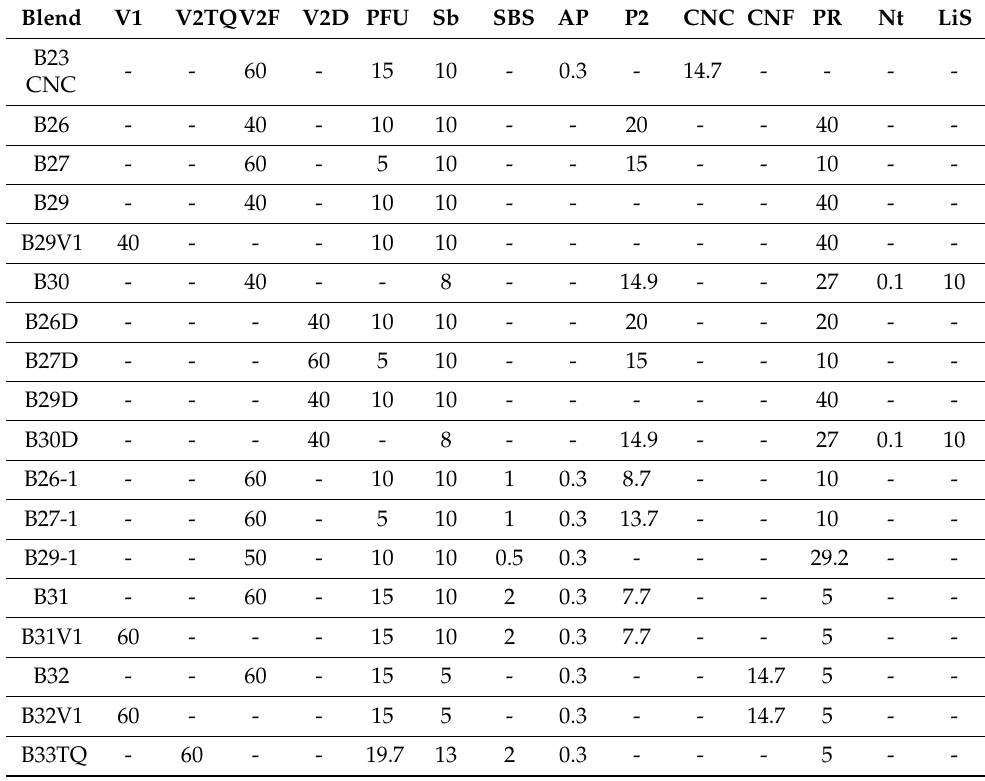
Table 2. Type and percentage of constituent materials of the 18 alternative